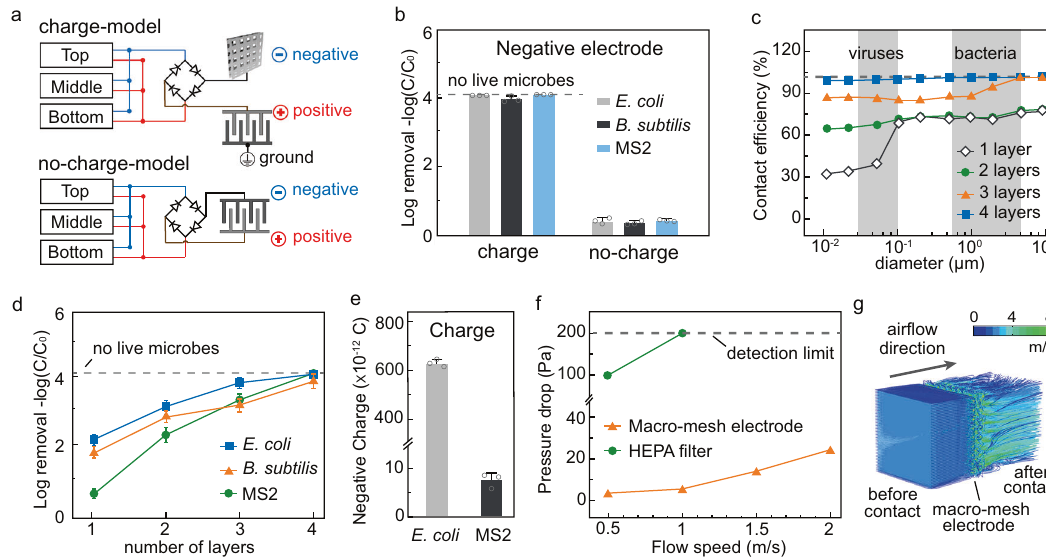
Fig. 4 Contribution of the macro-mesh negative electrode. a Schematics of the circuits for the charge-model (with the macro-mesh electrode; top) and no-charge-model (without the macro-mesh electrode; bottom) to investigate the contribution of the macro-mesh electrode in the RV-disinfection system. b Disinfection performance of the charge-model and the no-charge-model RV-disinfection systems for E. coli , B. subtilis , and MS2. Dashed lines indicate that all microbes are inactivated, and no live microbes can be detected. c Simulation of the contact ef fi ciency (percentages of particles with various diameters from 10 − 2 to 10 μ m that come into contact with the electrode) after fl owing through the mesh electrode with various numbers of layers (from 1 to 4 layers). Dashed lines indicate 100% contact ef fi ciency. d Disinfection performance of the RV-disinfection system using a macro-mesh negative electrode with various numbers of layers (from 1 to 4 layers). Dashed lines indicate that no live microbes can be detected. e Quantitative measurement of the charges carried by each E. coli and MS2 after fl owing through the macro-mesh negative electrode. In ( b – e ), the air fl ow rate was fi xed at 2 m/s, and the V- TENG was operated at a constant amplitude (500 μ m) and vibration frequency (30 Hz). f Pressure drops in air fl ows after passing through the RV- disinfection system with the macro-mesh electrode or with the high-ef fi ciency particulate air (HEPA) fi lter at various air fl ow rates (from 0.5 to 2 m/s). Dashed lines indicate the detection limit (200 Pa). g Simulation of the air fl ow fi eld before and after fl owing through the RV-disinfection system with the macro-mesh electrode at an air fl ow rate of 2 m/s. The error bars represent the standard deviation of three replicate